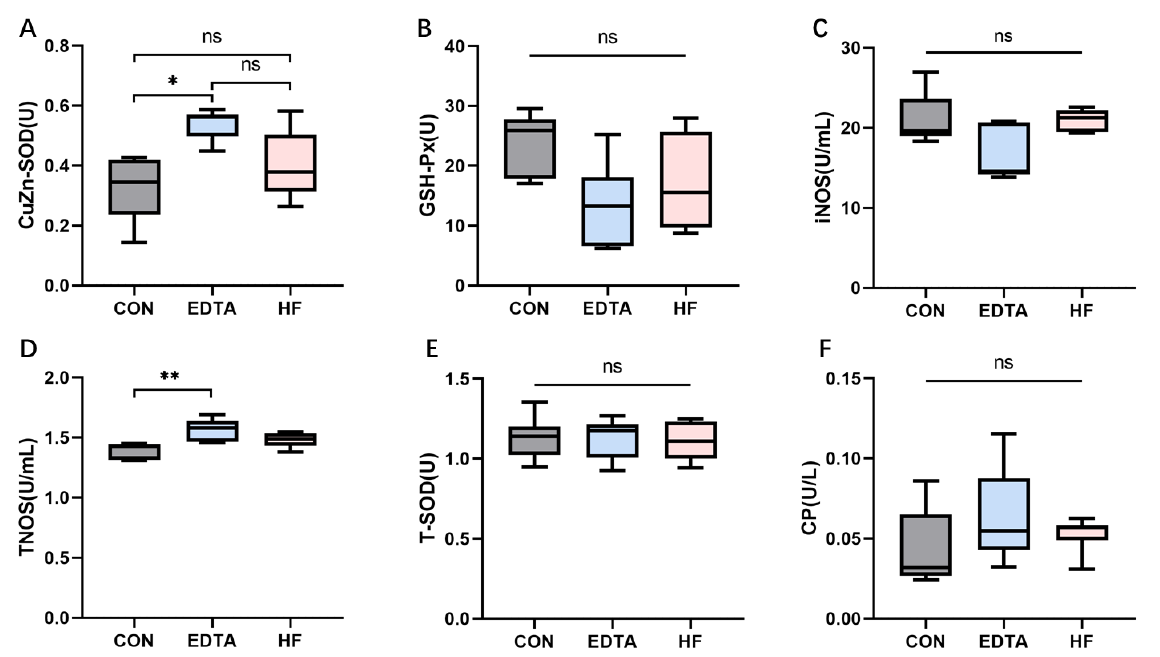
Figure 5. The activity of ( A ) CuZn-SOD, ( B ) GH-PX, ( C ) iNOS, ( D ) TNOS, ( E ) T-SOD and ( F ) CP in the serum of each group detected by colorimetric and hydroxylamine test methods. CON: control group, EDTA: experimental group, HF: recovery group. Statistically significant differences are indicated by * p < 0.05, ** p < 0.01.